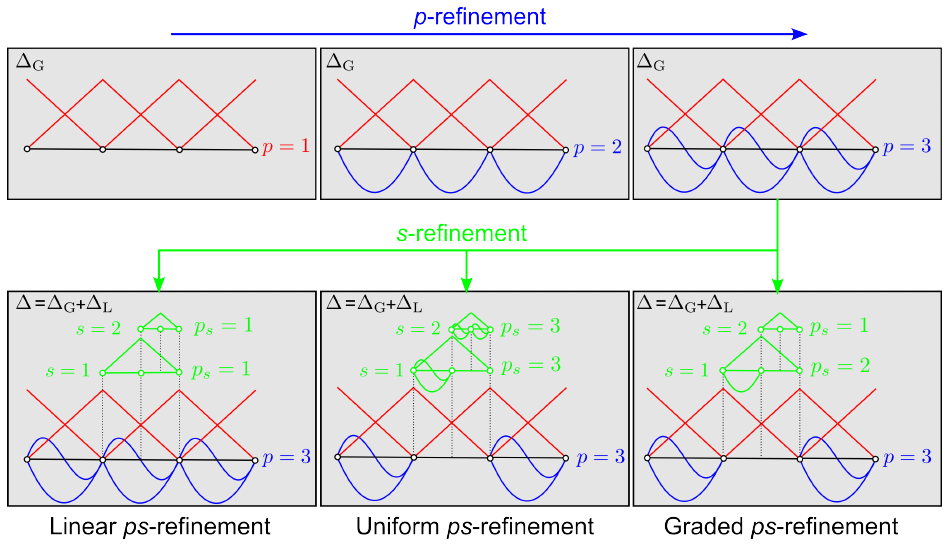
Figure 7. Refinement process in the ps −